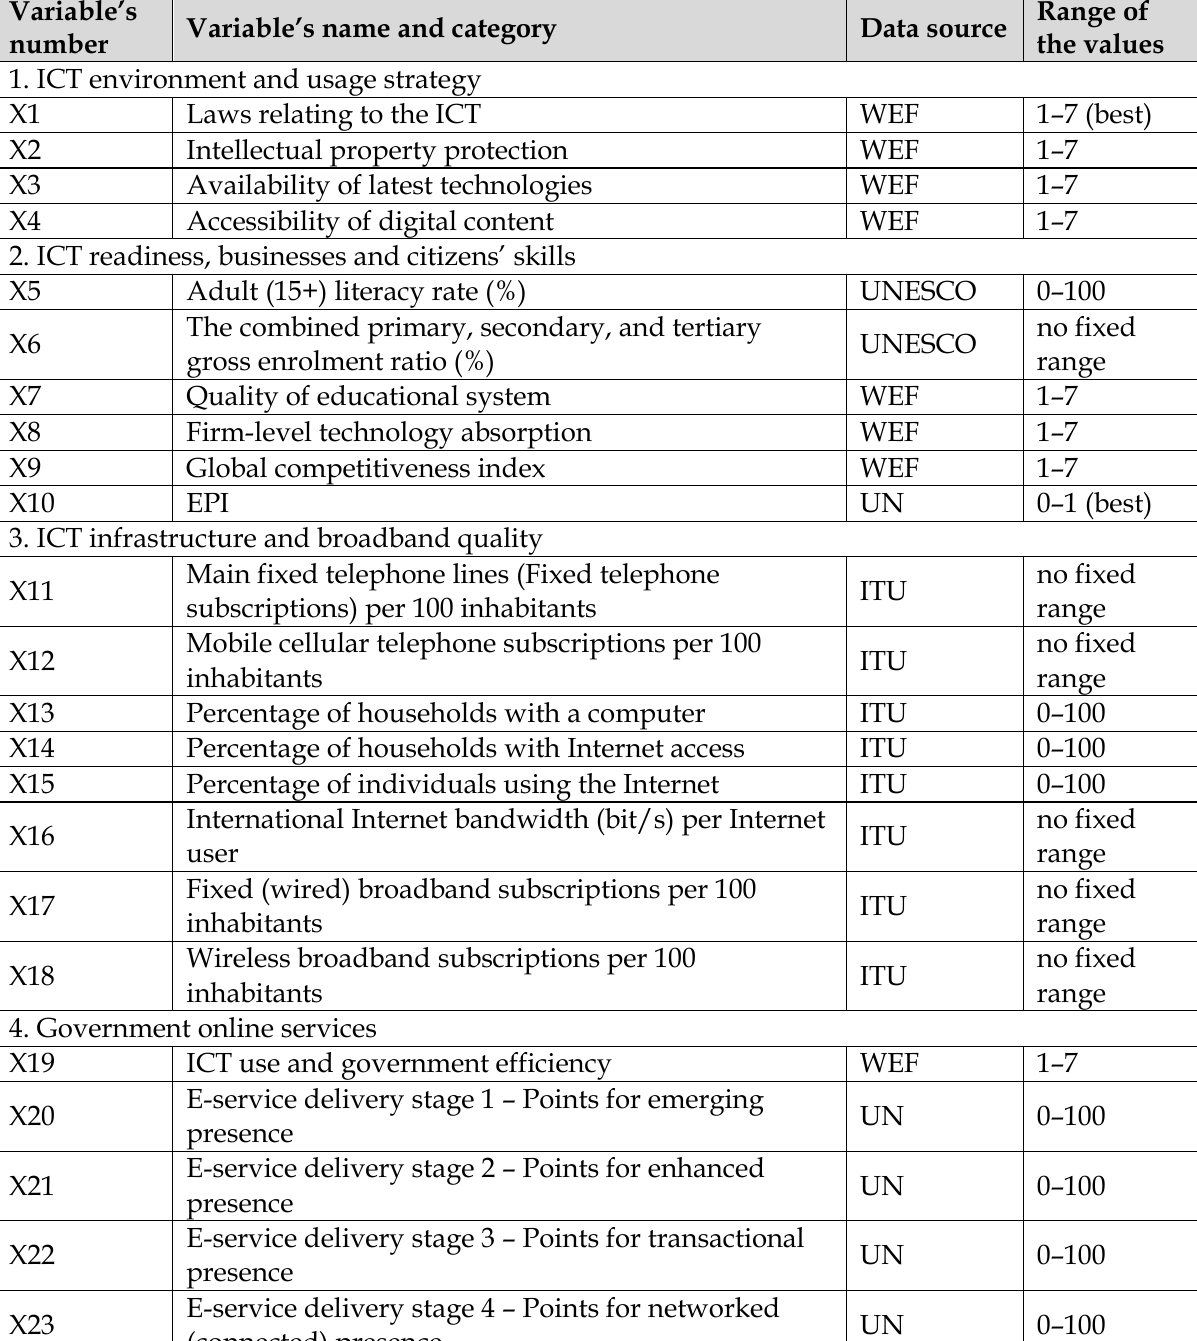
Table 2: Hierarchy of the variables for the modelling of the e-government development